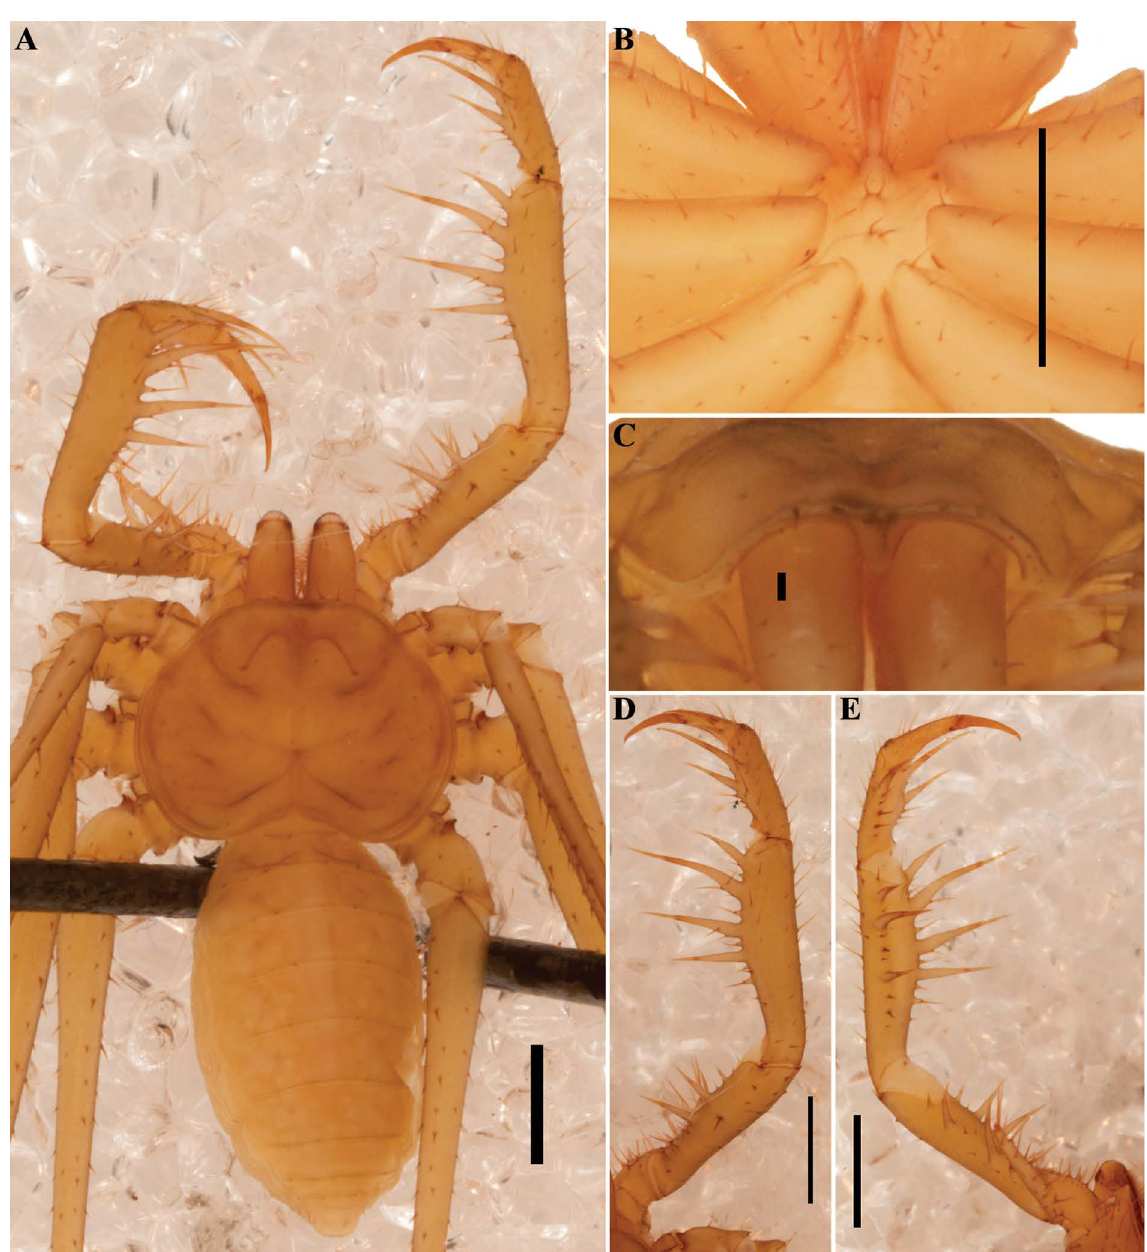
Fig. 149. Sarax stygochthobius (Weygoldt & Van Damme, 2004) comb. nov. (HLMD EA–172–HT), general morphology, ♂. A . Habitus, dorsal view. B . Sternum, ventral view. C . Frontal process. D . Pedipalp, dorsal view. F . Pedipalp, ventral view. Scale bars: A–B, D–E = 1 mm; C =